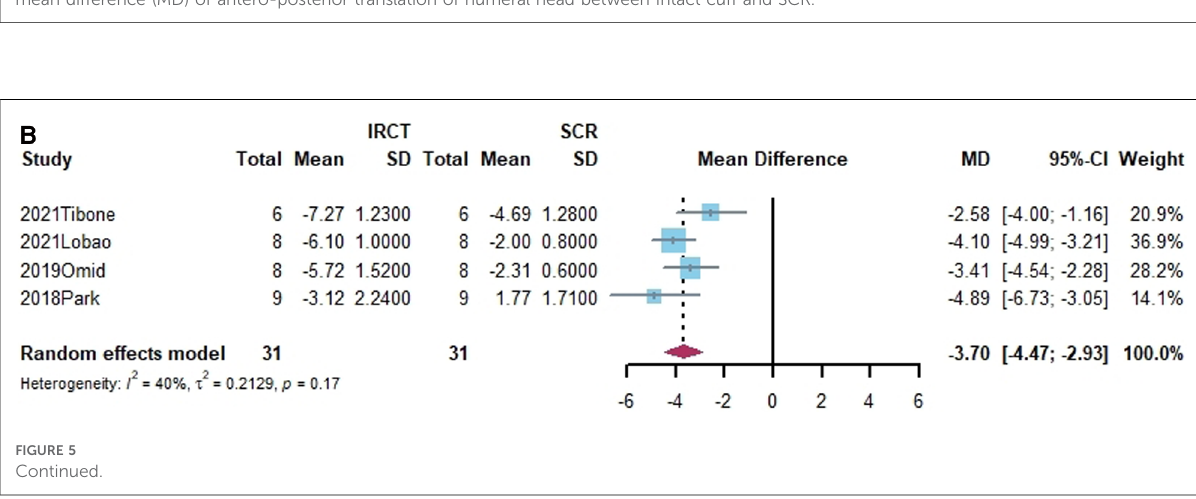
FIGURE 5 ( A ) Forest plot comparing the mean difference (MD) of antero-posterior translation of humeral head between Intact cuff and IRCT. ( B ) Forest plot comparing the mean difference (MD) of antero-posterior translation of humeral head between IRCT and SCR. ( C ) Forest plot comparing the mean difference (MD) of antero-posterior translation of humeral head between Intact cuff and